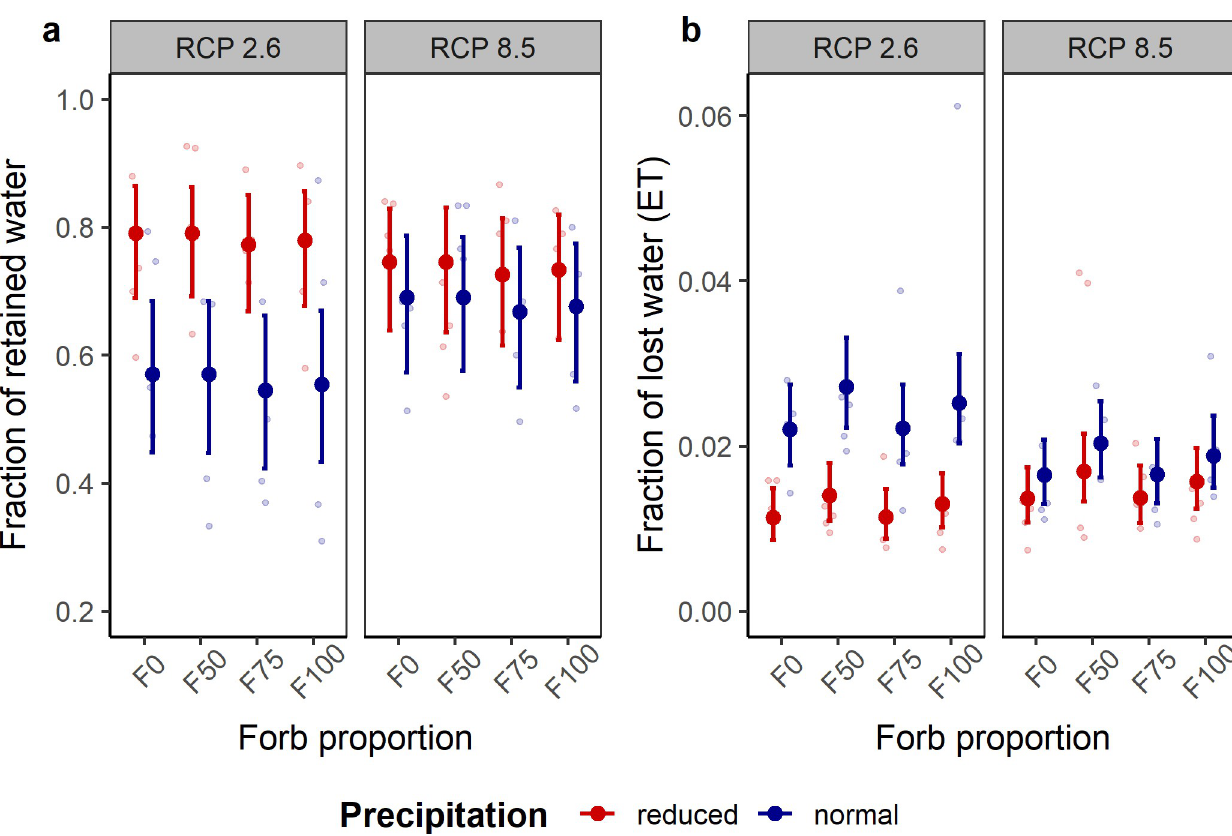
Fig 3. Effects of forb proportion, precipitation and climate change scenarios on water regulation in grasslands. (a) Fraction of retained, and (b) lost water by evapotranspiration [ET] (means ± 95% confidence intervals) of mesocosm communities in the climate chambers of the ecotron facility. A heavy- rain event was simulated to derive information on water regulation function. Data points are light-colored circles (n = 4).